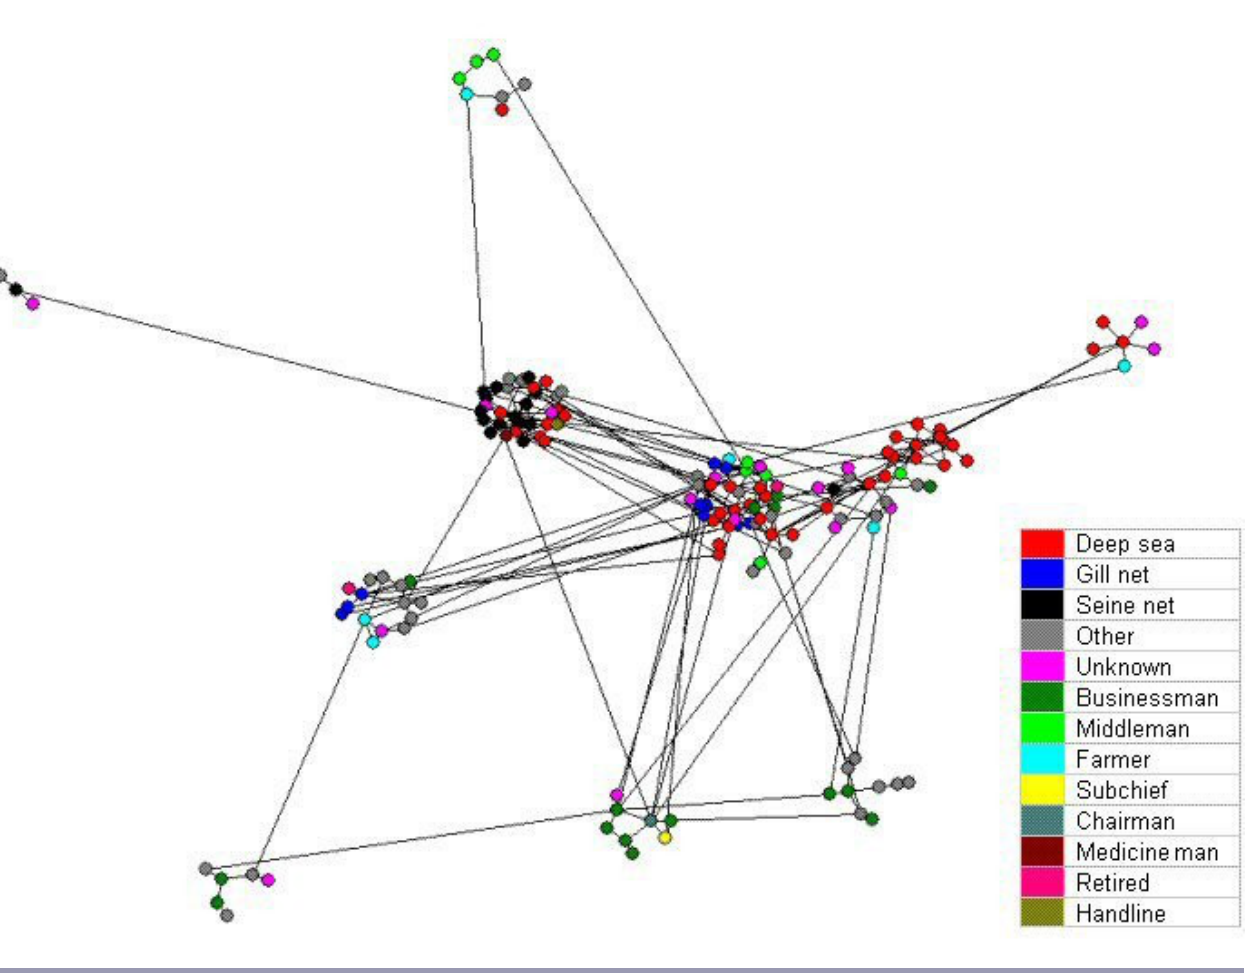
Fig. 4. Multidimensional scaling plot of group structure based solely on relations reported by respondents. The position of each individual node is estimated based on both within-group relations as well as relations to other individuals outside the individual’s own group. Groups are distinguishable as spatially clustered sets of nodes. Colors indicate the occupational category of each